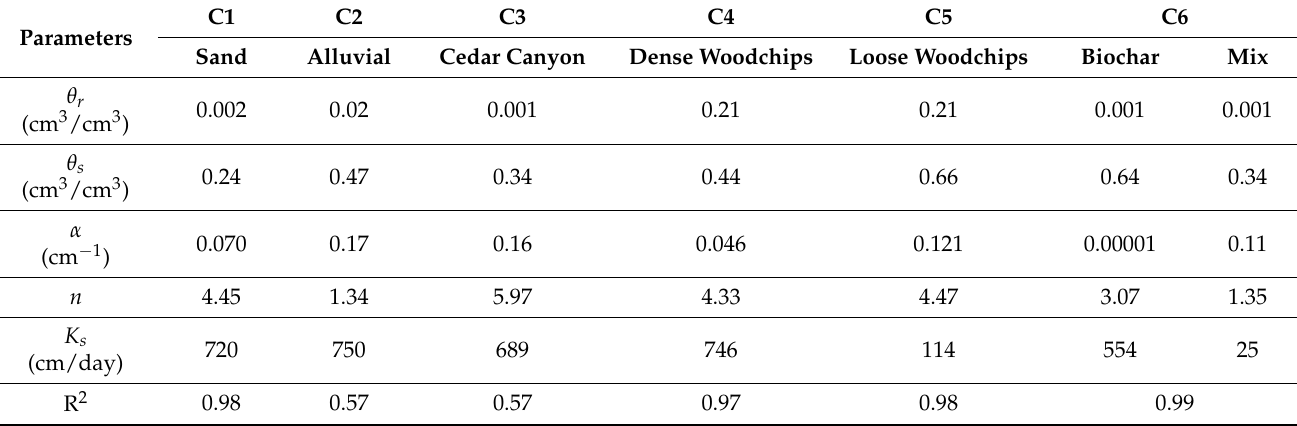
Table 2. Calibrated Hydraulic